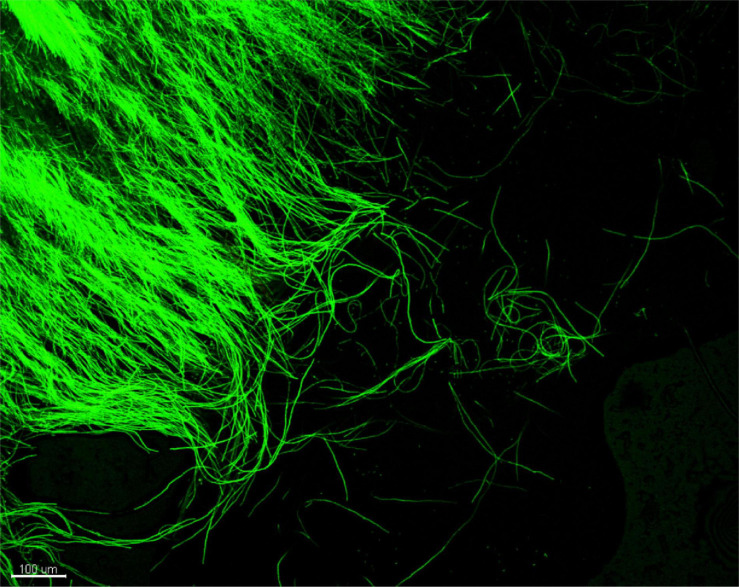
CLSM observation of Phaeoacremonium minimum::gfp7 from a pure MEA culture: peripheral hyphae from plate showing strong GFP fluorescence.